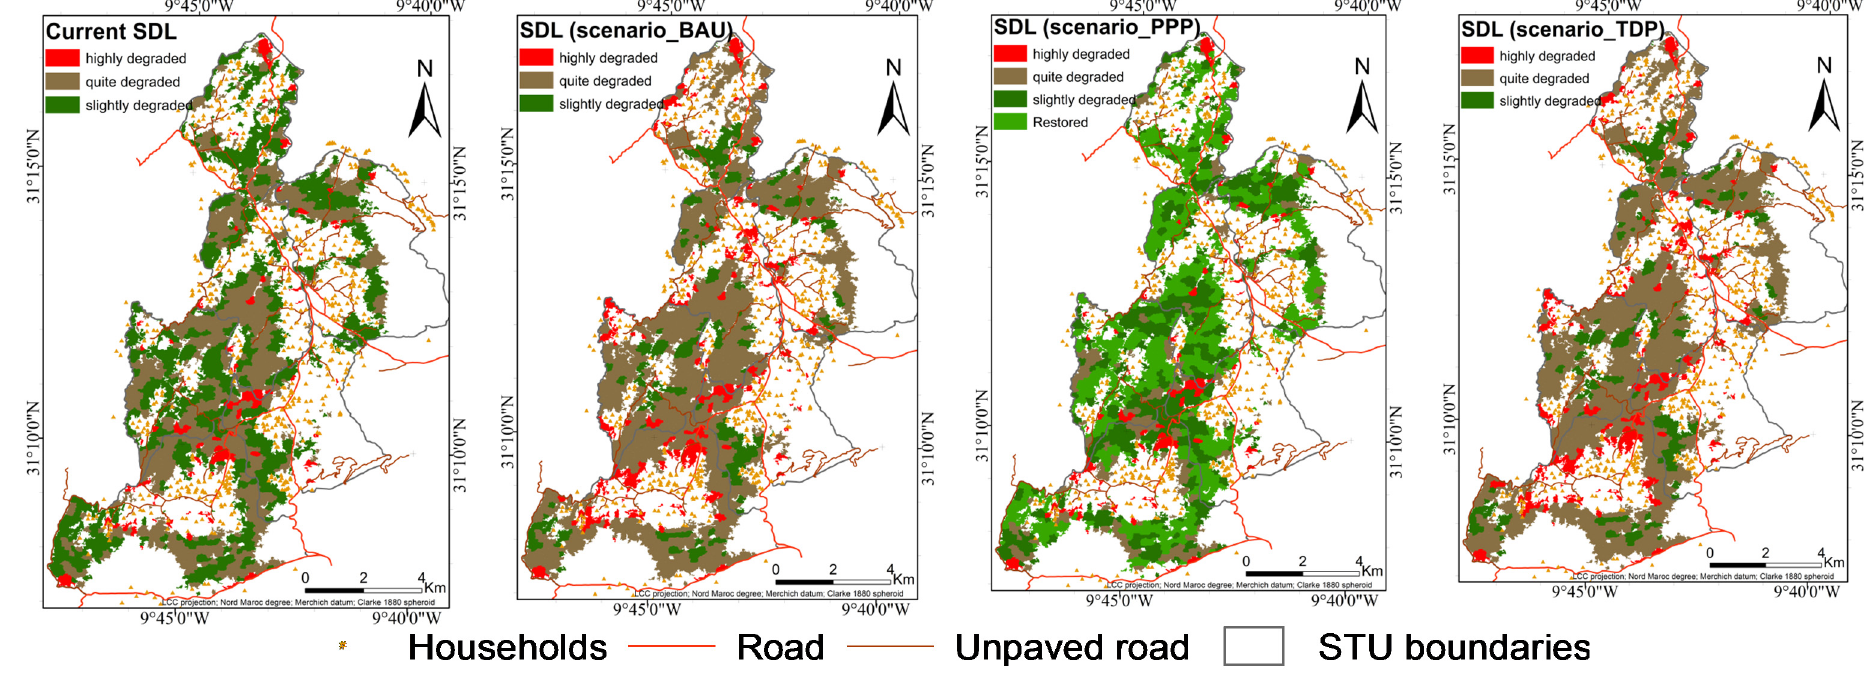
Figure 10. Current stand degradation level and simulated stand degradation level after a 30-year simulation period for scenarios BAU , PPP and TDP (the degradation level of the plots corresponds to the degradation level that has the maximum